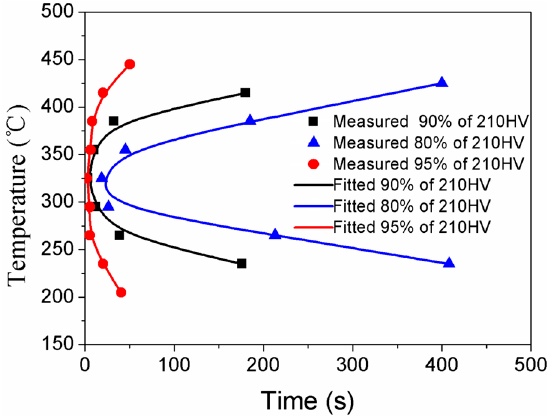
Figure 11. The time-temperature-property (TTP) curves of the studied alloy subjected to have been solid solution treated at 470 °C for 1 h, isothermal heat treatment for various durations, and then aged solid solution treated at 470 ◦ C for 1 h, isothermal heat treatment for various durations, and then aged at 120 °C for 24 h. at 120 ◦ C for 24